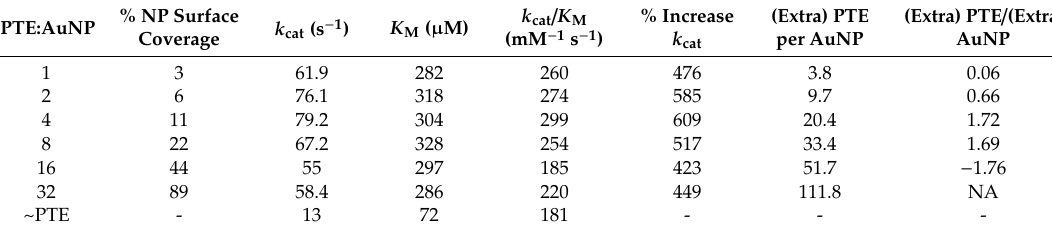
Figure 5. Kinetics of enzymes immobilized at fixed enzyme density or fixed NP diameter. ( a ) Schematic highlight the two di ff erent experimental formats utilized in Breger et al. A fixed enzyme density keeps the coverage per unit area of the NP constant across the NP size series while the fixed NP diameter varies the number of enzymes per NP while keeping the NP size constant. Note that both formats kept the enzyme concentration constant; ( b ) Plot of binned k cat value ranges as a function of AuNP diameter and %PTE coverage in a topographical format. Note values for the 100 nm AuNPs at lowest coverage were not collected and are extrapolated here. Reproduced with permission from ref. [76]. Copyright Table 4. Averaged enzyme activities for fixed NP diameter format on 10 nm AuNPs.